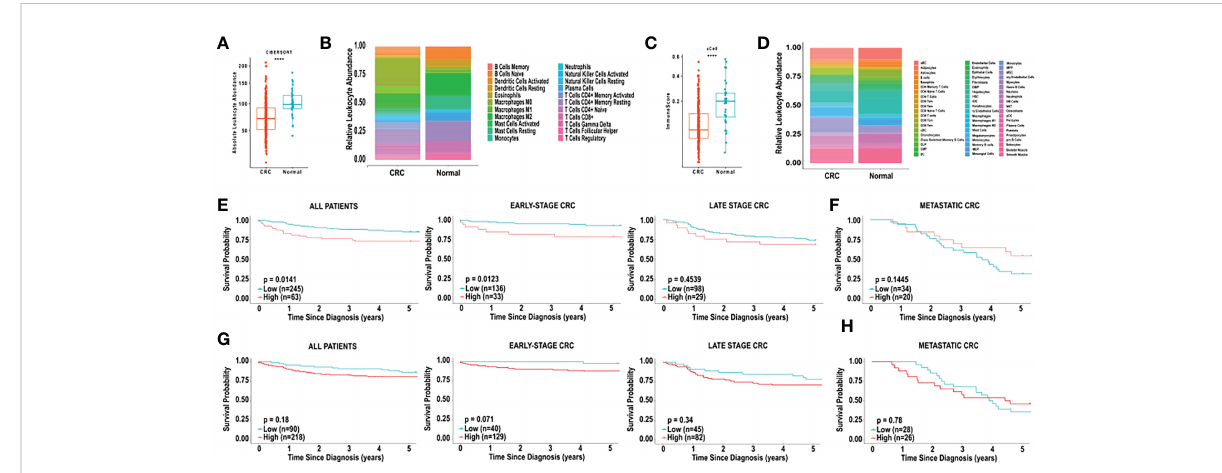
FIGURE 2 Analysis of immune cell composition and survival of CRC using CIBERSORT and xCell. (A) Relative leukocyte fractions of 22 cell types were determined using CIBERSORT for 308 CRC tumours and 40 normal adjacent colon tissue samples. Absolute leukocyte abundance was determined by the sum of all immune cell in fi ltration, based on CIBERSORT, for CRC tissue and normal adjacent colon tissue. Each dot represents one patient. (B) Relative leukocyte fractions are depicted for CRC tissue and normal adjacent colon tissue, as predicted by CIBERSORT. (C) The Immunoscore, as determined by xCell, for CRC tissue and normal adjacent colon tissue. (D) Relative leukocyte fractions are depicted for CRC tissue and normal adjacent colon tissue, as predicted by xCell. (E) Kaplan-Meier curves for overall fi ve-year survival based on the CIBERSORT absolute leukocyte abundance for all TCGA patients, patients with early-stage CRC, late-stage CRC and (F) metastatic CRC. (G) Kaplan-Meier curves for overall fi ve-year survival based on the xCell Immunoscore for all TCGA patients, patients with early-stage CRC, late- stage CRC and (H) metastatic CRC. CRC was compared to normal tissue using the Wilcoxon test. ****p < 0.0001. Groups with high and low cell numbers were compared with log-rank